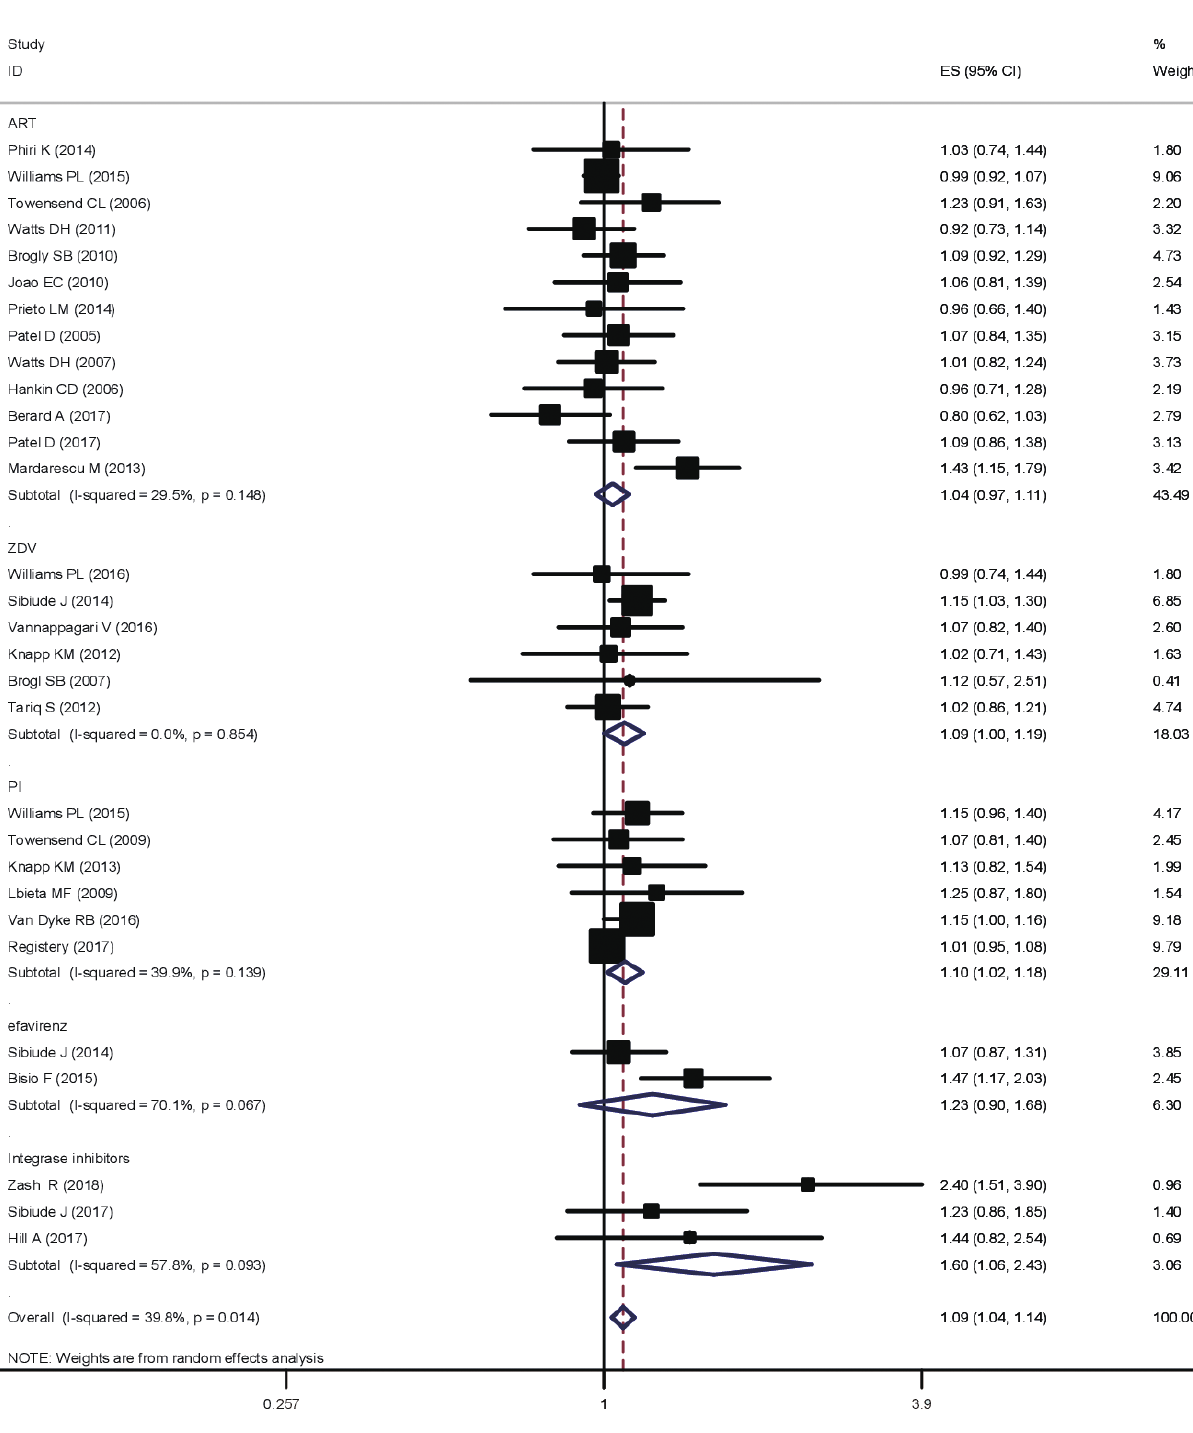
Figure 4. Subgroup analysis of the effects of different categories of ART on the risk of congenital anomalies. ES, effect size; CI, confiedence interval; ART, antiretroviral therapy; ZDV, zidovudine; PI, protease alies (events) in the ART group (intervention group) is displayed and the size of the circle is proportional to study size. The 45° line on the y-axis and the event rate in the ART-naïve group (control is the line of no effect. The summary effect shows that ART has a group) on the x-axis. Each circle represents an individual study small but significant causal effect on congenital anomalies.